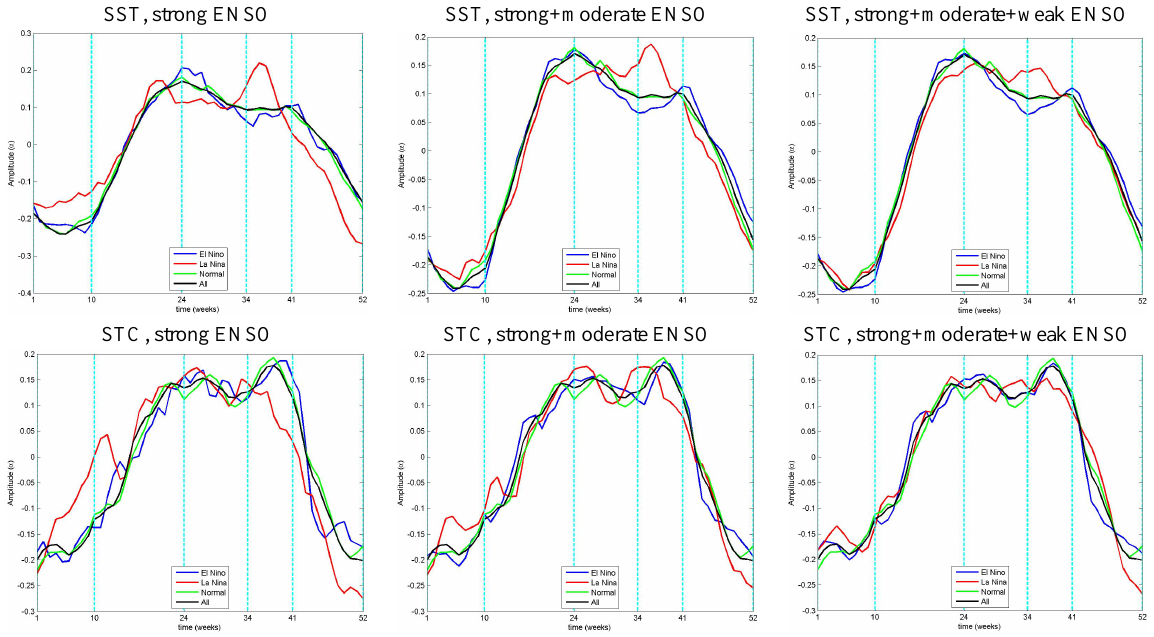
Fig. 11. Time-dependent amplitudes of the most dominant mode obtained from EOF analysis of SST (top) and STC values (bottom). Strong El Ni˜no and La Ni˜na years (left column), strong + moderate (middle column) and strong + moderate + weak ENSO years are used (Table 1). In all plots, the normal and all year groups do not vary (Table 1). STC parameters: s = 3, c = 3 and moving average threshold j =